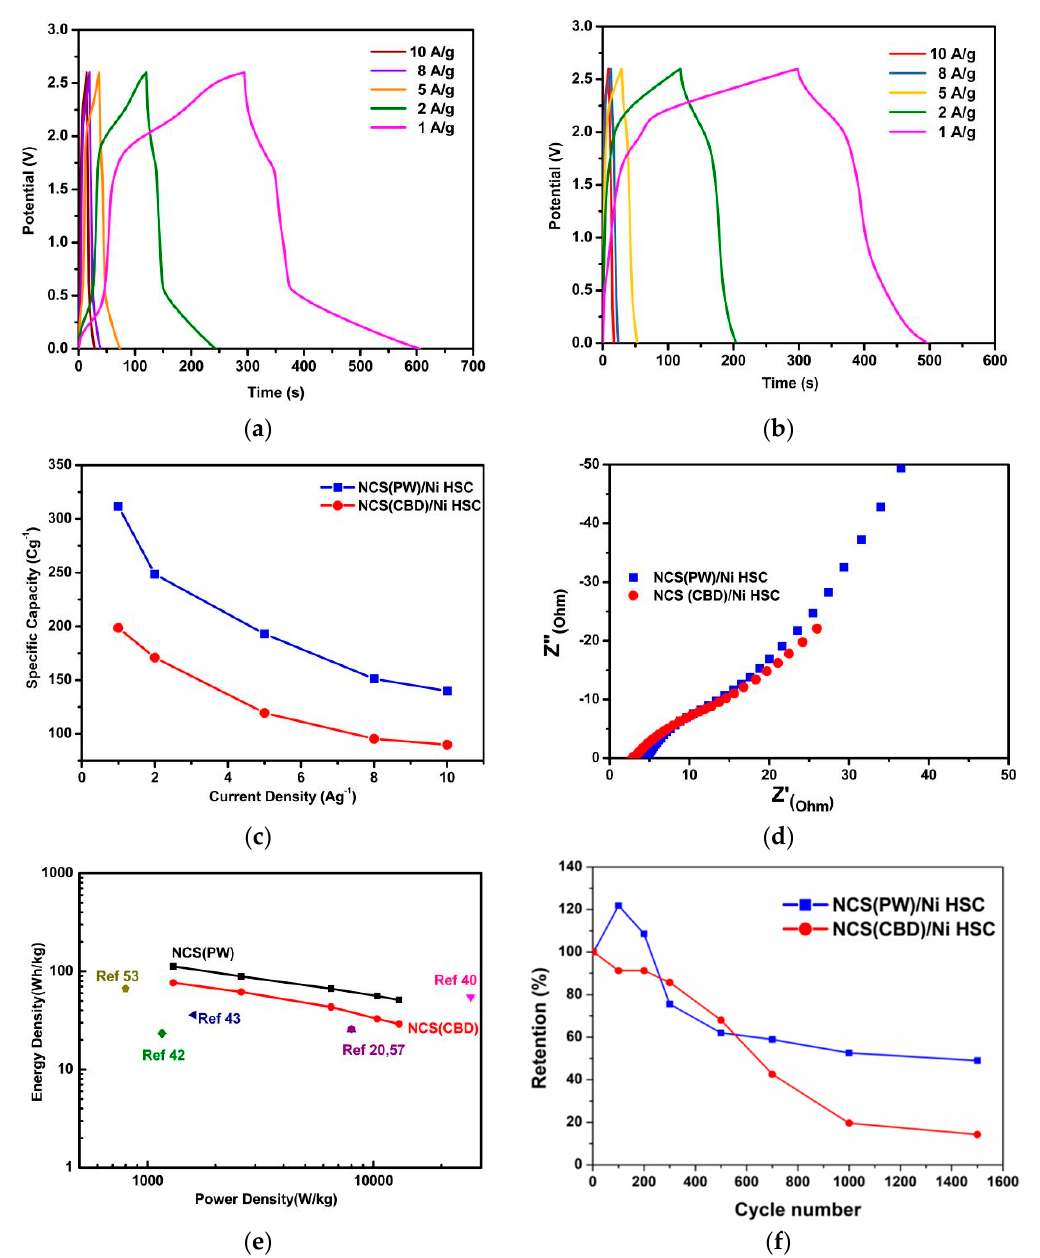
Figure 6. Electrochemical evaluation of NCS(CBD)/Ni and NCS(PW)/Ni HSCs: ( a ) CP analysis of the NCS(CBD)/Ni HSC; ( b ) CP analysis of the NCS(PW)/Ni HSC; ( c ) the comparative specific capacities of NCS(PW)/Ni and NCS(CBD)/Ni HSCs, ( d ) the EIS curves of the assembled HSCs, ( e ) Ragone plot of energy vs. power density for NCS(PW)/Ni and NCS(CBD)/Ni HSCs; ( f ) cyclic stability results of NCS(CBD)/Ni and NCS(PW)/Ni HSCs analyzed for 1500 cycles.